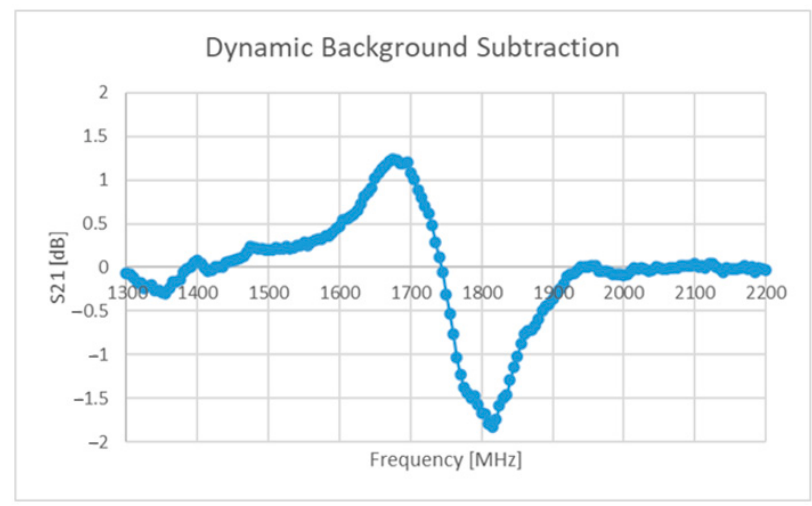
Figure 15. Resulting signal from subtraction operation.